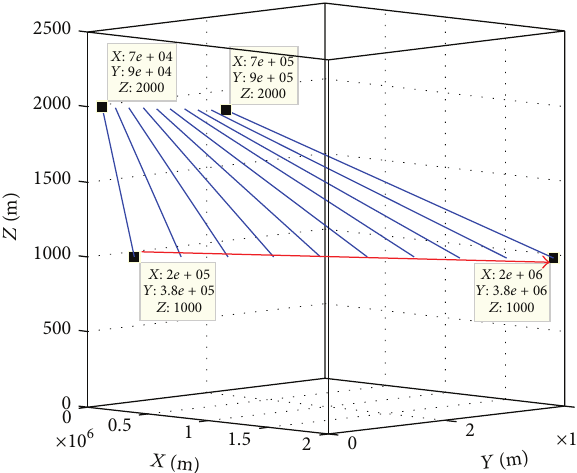
Figure 9: Simulated lightning leader at various distances from the sensor station to determine its effect on the model computation errors. Figure 10: The variation of (average) error in degrees for 𝛽 with